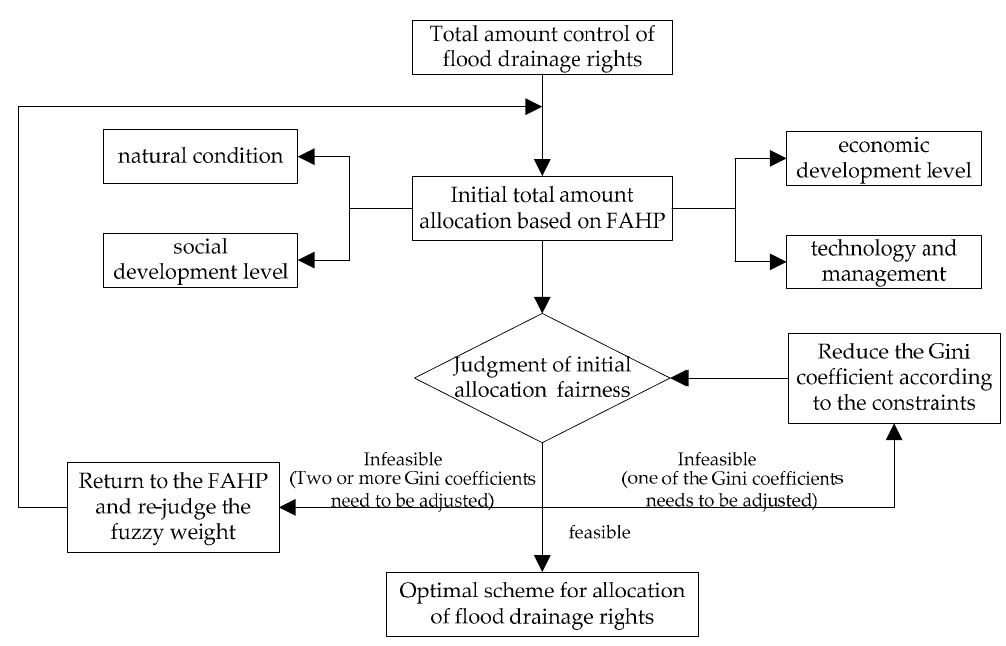
Figure 3. Technical route of feedback optimization.